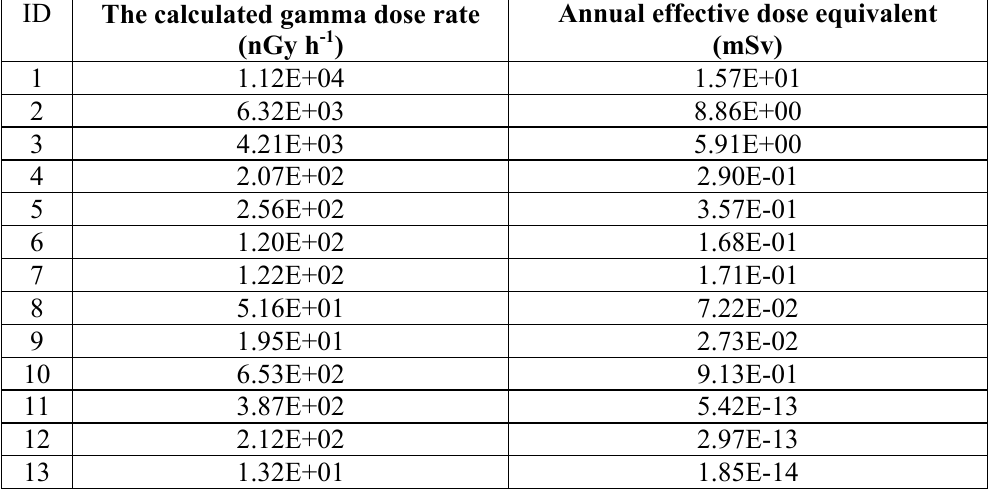
Table 4: The calculated gamma dose rate from 137 Cs, 60 Co and 40 K and annual effective dose equivalent